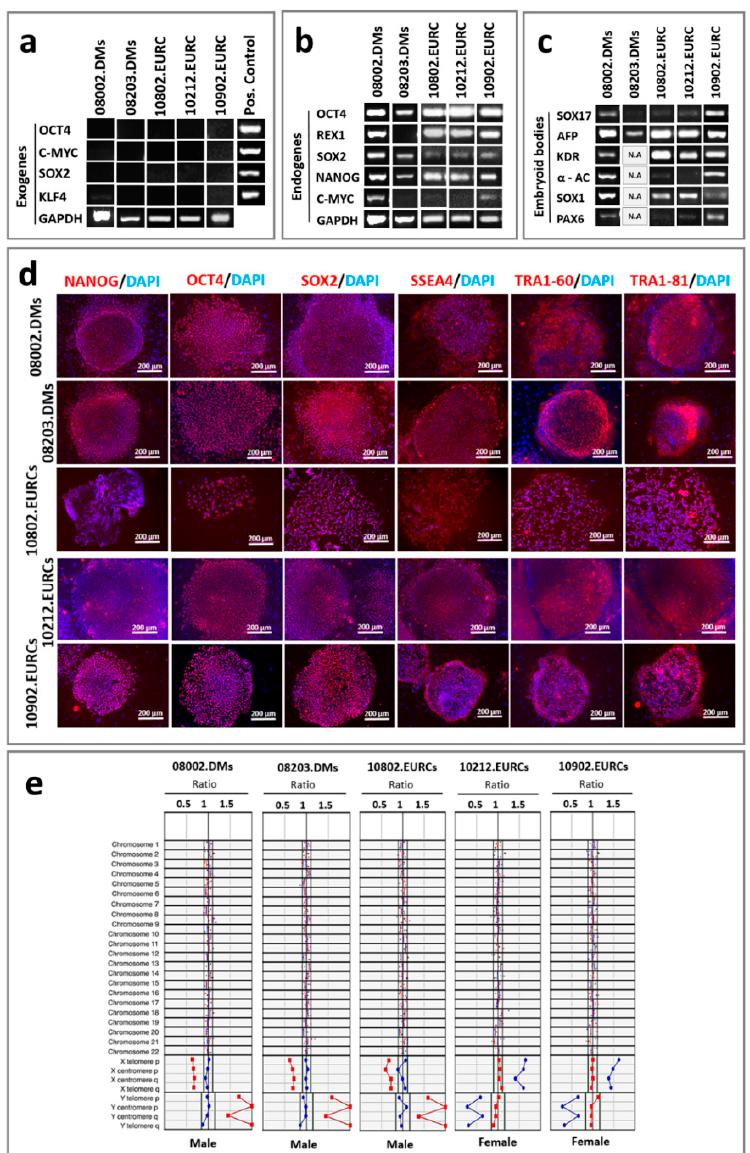
Figure 2. Characterization of the human induced pluripotent stem cell (hiPSC) line gene and protein expression and analyses of their karyotype. ( a ) The virally transferred Sendai exogenes OCT4 , c-MYC , SOX2 , and KLF4 were silenced in all the iPSC lines. The RNA that was extracted one week after the viral transduction was taken as a positive control. GAPDH was used as a housekeeping gene. ( b ) All the five hiPSC lines expressed endogenous pluripotency genes OCT4 , REX1 , SOX2 , NANOG , and c-MYC . ( c ) All five hiPSC lines formed embryoid bodies (EBs) expressing at least one marker from each of the germ layers: endoderm (AFP, SOX17), mesoderm (KDR, α -cardiac actin α AC), and ectoderm (SOX1, POX6). ( d ) The expression of pluripotency markers in all iPSC lines were confirmed at the protein level using indirect immunofluorescence staining. The red color indicates the specific signal for NANOG, OCT4, SOX2, SSEA4, TRA1-60, and TRA1-81, and the blue color indicates the nuclei stained using DAPI (4 (cid:48) ,6-diamidino-2-phenylidole). The scale bar represents200 µ m. ( e )KaryotypeanalysesoffivehiPSClines. Redandbluedotsindicatechromosomalsignal ratios of sample DNA against male (blue) or female (red) reference normal karyotype DNA, as detected using a KaryoLiteTM BoBs ™ assay. Signal from normal chromosomes should lie inside the reference area around value 1, while with an abnormal karyotype, signals lie outside the reference area. Cell lines UTA.08002.DMs, UTA.08203.DMs, and UTA.10802.EURCCs showed a normal male karyotype, and cell lines UTA.10212.EURCCs, and UTA.10902.EURCCs showed a normal female